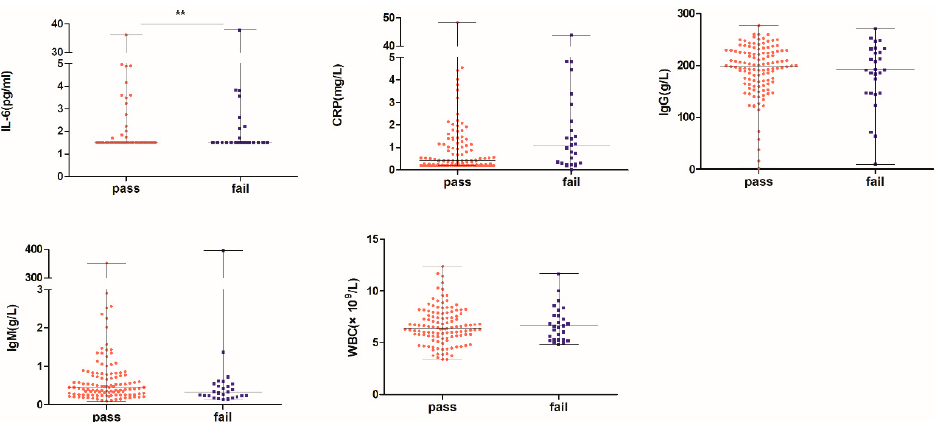
Figure 2. Comparison of inflammation factors between PASS group and FAIL groups. ** p < 0.05.